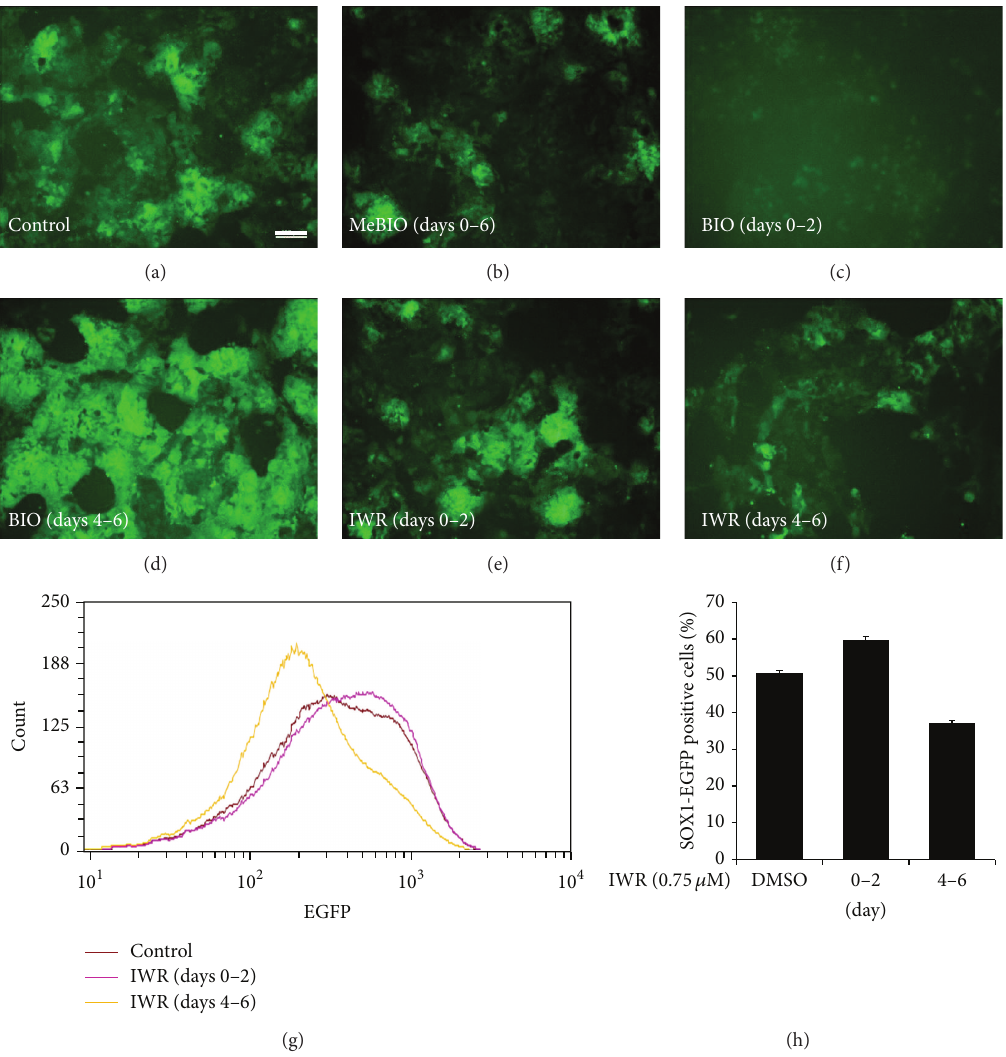
Figure 5: Decrease in neural differentiation of precursor cells by an Axin stabilizer (IWR-1-endo) from days 4 to 6 in N2B27 medium. (a)–(f) GFP expression of 46C cells was elevated by BIO treatment (0.75 𝜇 M) from days 4 to 6, whereas it was reduced by IWR-1-endo (0.75 𝜇 M) treatment from days 4 to 6. Cells were cultured in N2B27 medium for 6 days. (g) FACS analysis of Sox1 -GFP expression during monolayer differentiation in N2B27 medium. (h) Proportions of Sox1 -GFP expressing cells as determined by FACS. Scale bars, 100 𝜇